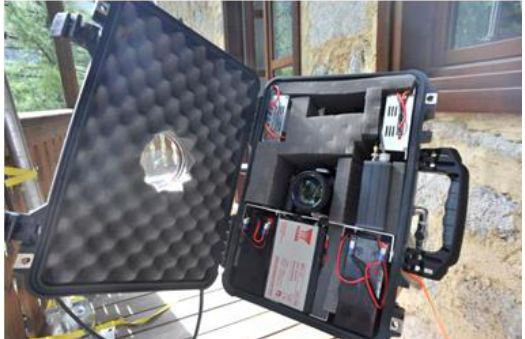
Figure 2: The watertight IP67 box housing all the acquisition and transmit equipment.